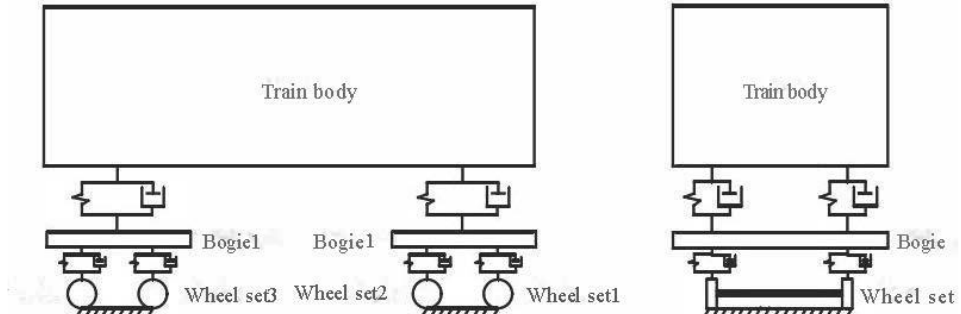
Figure 9. Front view and side view of train dynamics model.